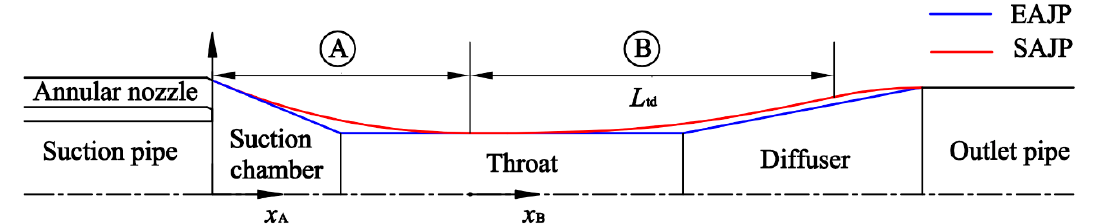
Figure 3. Profiles of the EAJP and SAJP.